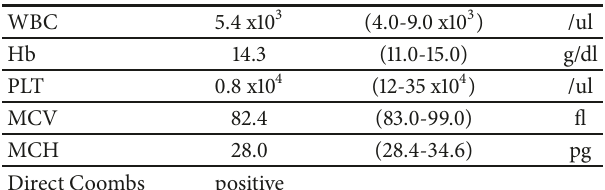
Table 2: Total blood count data when thrombocytopenia developed at 203 days after delivery (reference ranges are